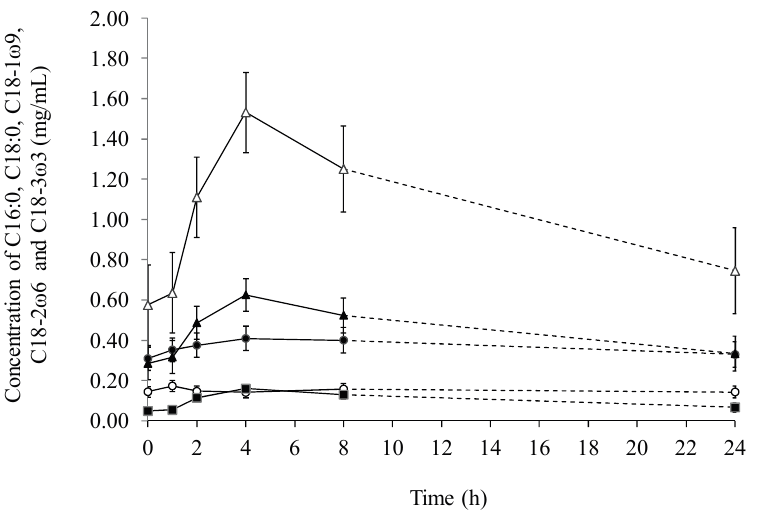
Figure 2. The average lymphatic concentration (mg/mL) of palmitic (16:0, ● ), stearic (18:0, ○ ), oleic (18:1 ω 9, ▲ ), linoleic (18:2 ω 6, ∆ ) and linolenic (18:3 ω 3, ■ ) acid across diets over